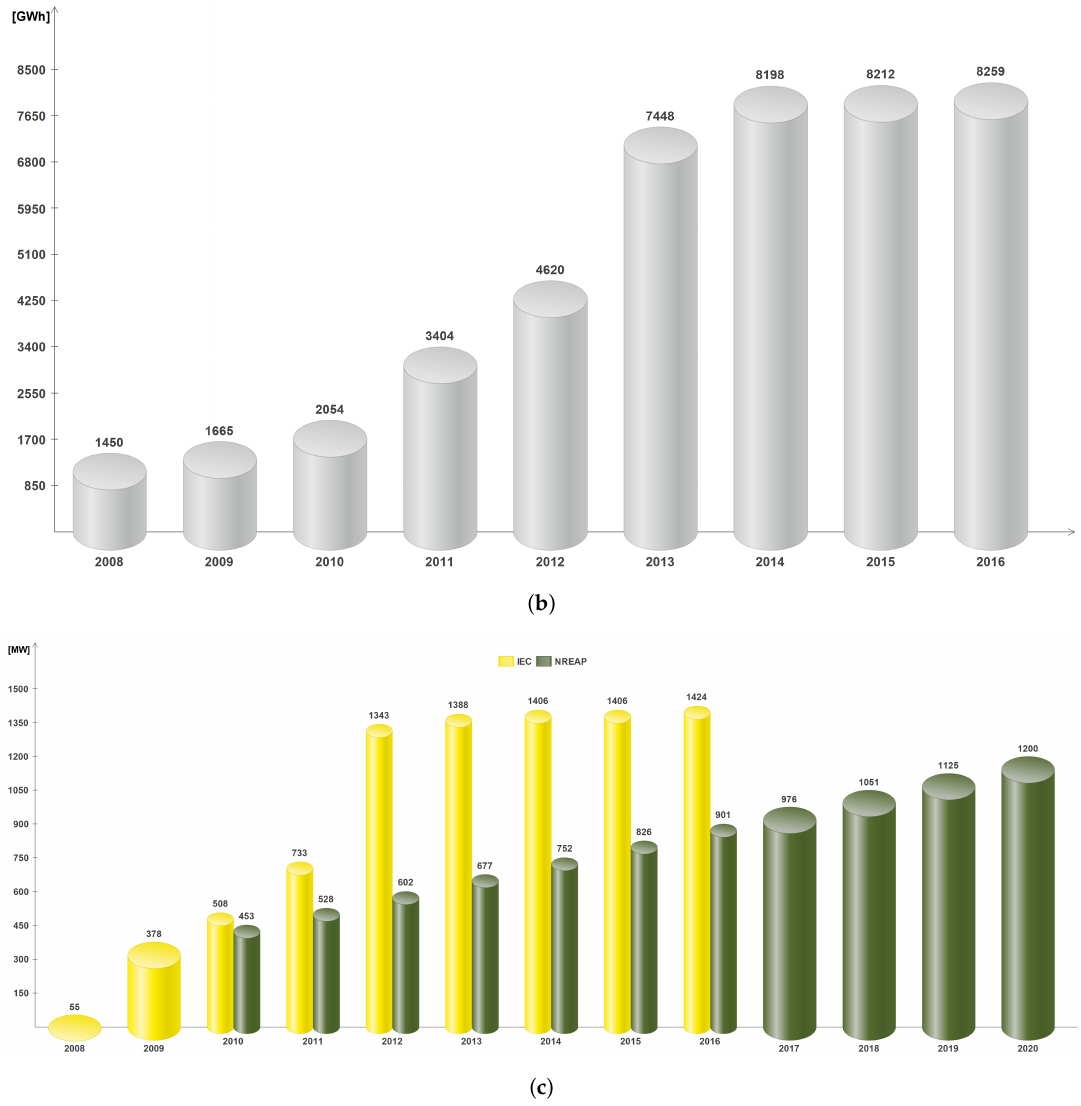
Figure 8. Evolution of the Italian biogas plants in terms of ( a ) numerousness, ( b ) Electricity production and ( c ) Installed Electricity Capacity compared to Italian NREAP yearly targets. Data from: References